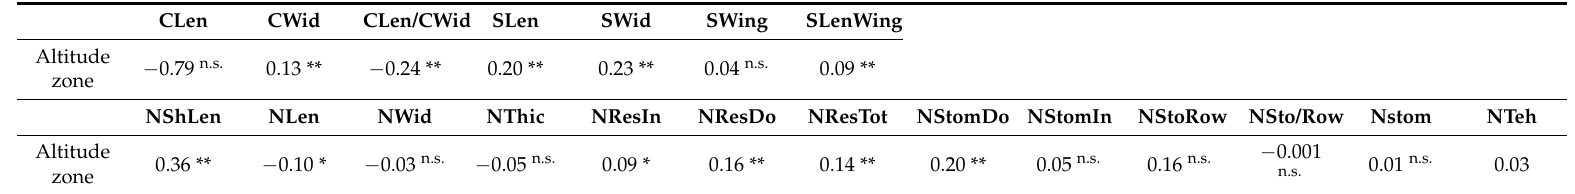
Table 5. Results of Pearson Correlation coefficient between investigated morphoanatomical traits and the sampled altitudinal subpopulations (PaZ.400, PaZ.800, and PaZ.1200).